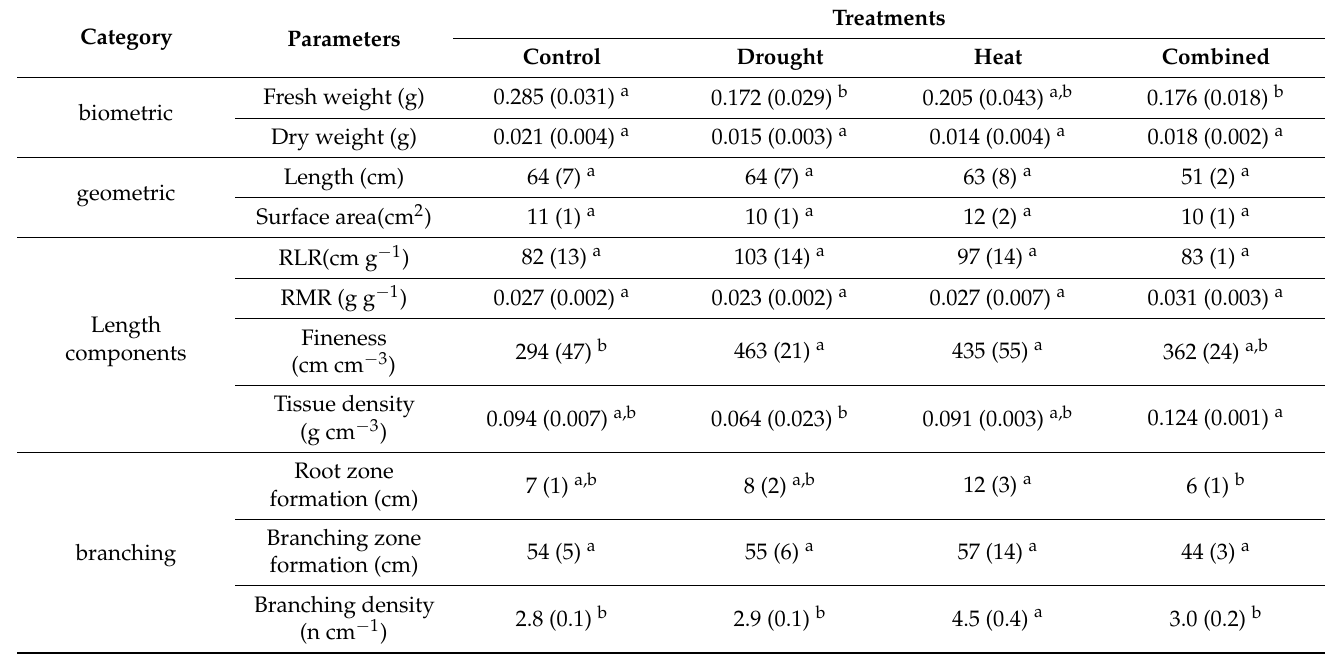
Table 2. Morphology of seminal root of maize plants exposed to single (drought and heat) and combined stress (drought + heat). Category